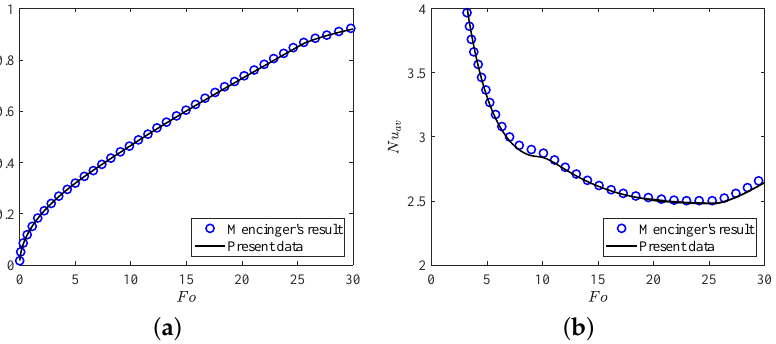
Figure 2. The comparisons of ( a ) total liquid fraction and ( b ) average Nusselt number with Fo between present numerical results and Mencinger’s [64] results. Parameters: Ra = 2.5 × 10 4 , Pr = 0.02, Ste = 0.01.